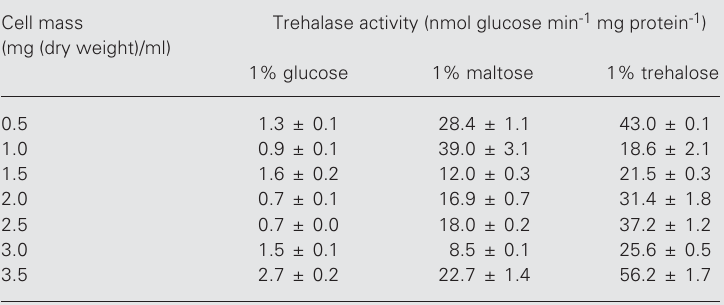
Table 2. Trehalase activity during growth of Candida utilis in glucose, maltose and